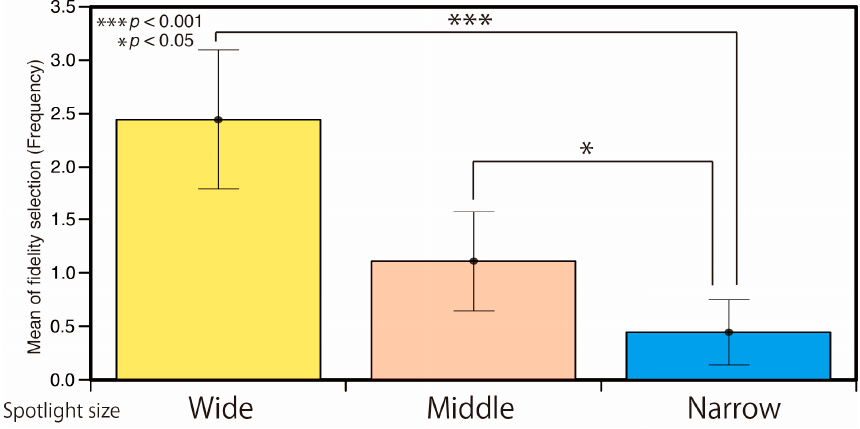
Figure 10. Result of fidelity selection for each spotlight size condition.